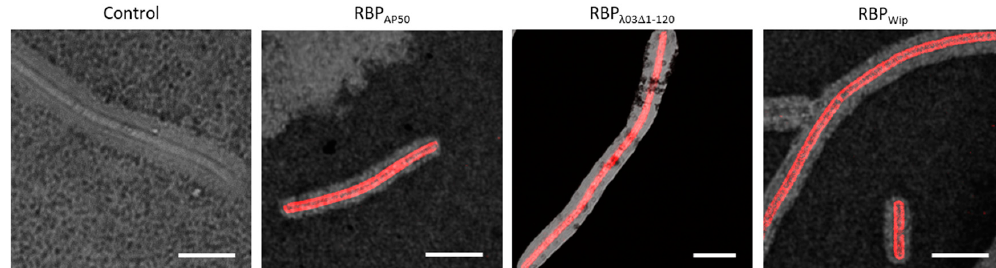
Figure 6. Binding of RBP reporters to encapsulated cells of B. anthracis . Fresh cultures of B. anthracis Fig6 strain Ames inoculated from overnight cultures were grown for 4 h under capsule-inducing conditions and then inactivated by peracetic acid treatment. Cells were incubated with RBP reporters (RBP AP50 , RBP λ 03 ∆ 1-120 or RBP Wip ) or no RBP (control) and subjected to fluorescence microscopy in the presence of negative-staining ink. Representative micrographs were recorded as merged light and fluorescence channels. Scale bars: 10 µ